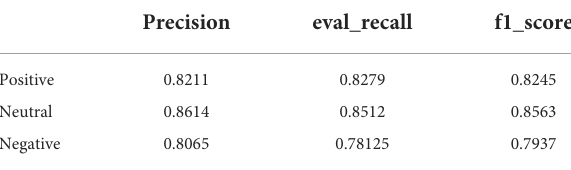
TABLE 2 Chinese-RBT3 pre-training model test results.